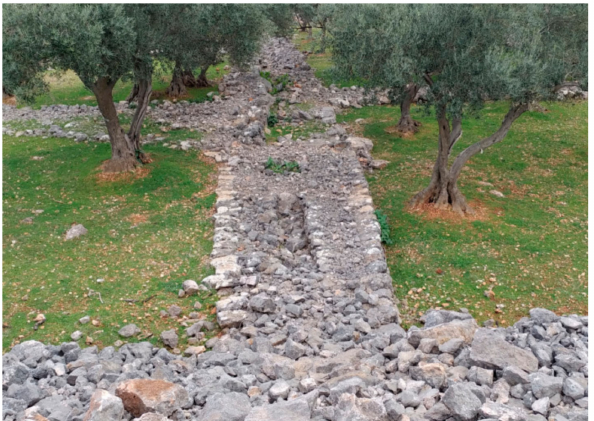
Figure 28. Dry stone details: a hole intended for lowering the donkey’s height on which the bag with olives or grapes was placed (Franko Fuˇci´c,